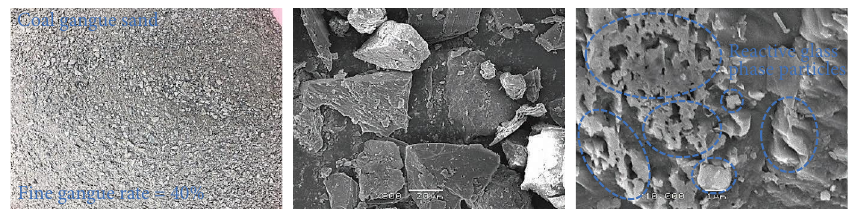
Figure 3: Te morphology and microstructure of coal gangue